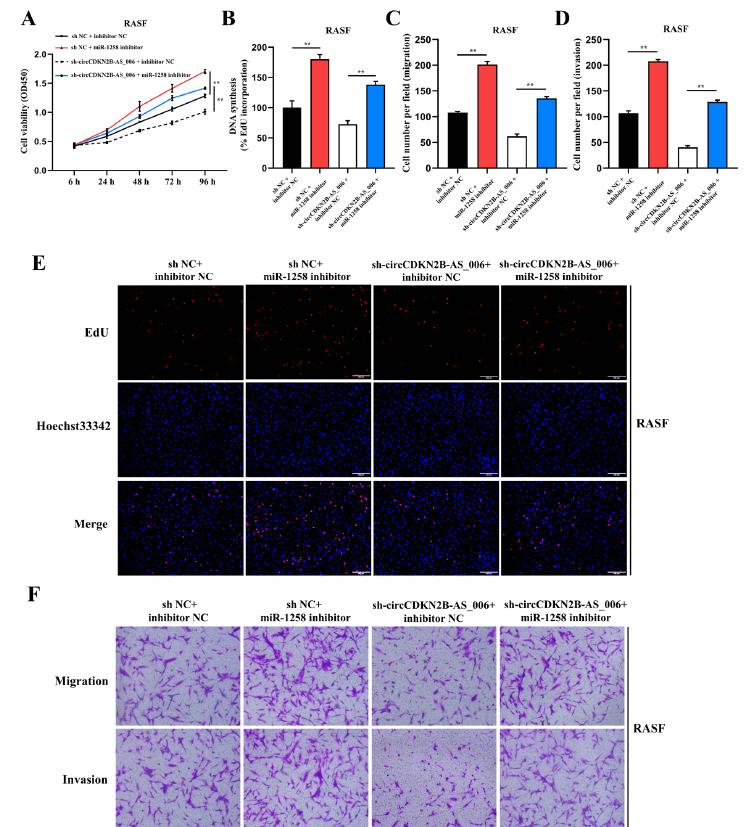
Figure 4. MiR−1258 reverses circCDKN2B−AS_006 - promoted cell proliferation, migration, and invasion of RASFs. ( A , B , E ) The cell proliferation levels were determined after transfection with sh−circCDKN2B−AS_006 and miR−1258 inhibitors via the CCK−8 ( A ) and EdU assays ( B , E ). ( C , D , F ) After transfection with sh−circCDKN2B−AS_006 and miR−1258 inhibitors, the cell migration and invasion of RASFs were determined by means of transwell assay. ** p < 0.01 .